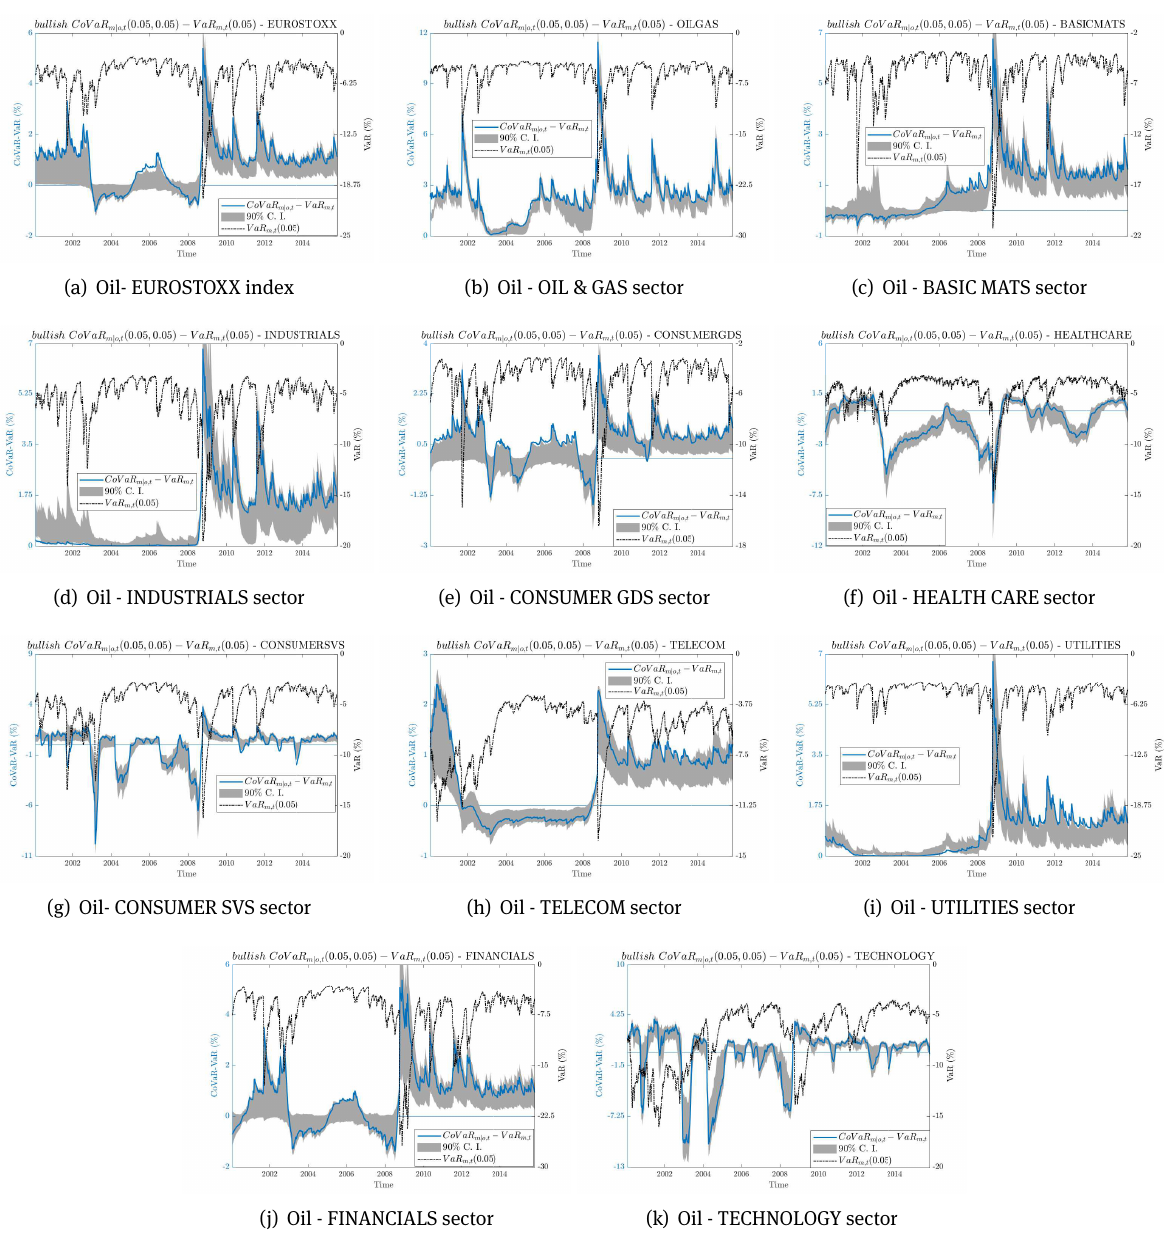
Figure 9: CoVaR m | o , t (0.05, 0.05) for a certain sector given a bullish scenario for oil